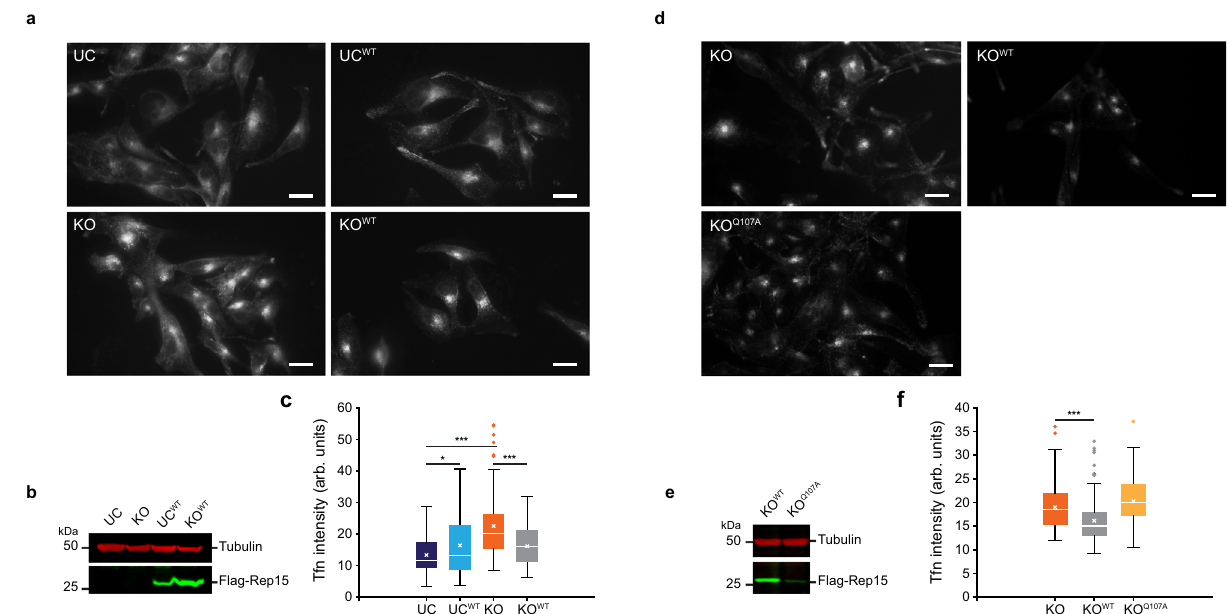
Fig. 9 Rep15 KO U138MG cells show reduced transferrin recycling. a Rep15 KO shows signi fi cant retention of Alexa-488-conjugated human transferrin in the 2 h chase post 30 min. internalization (representative pictures). Scale bar, 10 µ m. Overexpression of the WT-Rep15 further increased the transferrin retention in the WT cells (UC WT ; light blue bar) while, decreasing it, in the Rep15 KO cells (KO WT ; gray bar). b Western blot con fi rmation of the overexpression of Flag-tagged WT-Rep15. c Quanti fi cation of retained transferrin in the respective cell line presented in a ( n = 60; cells were examined over three independent experiments). d The rescued KO cells with the WT Rep15 (KO WT ; gray bar) show a signi fi cant reduction in the transferrin retention in the chase experiment, while the Q107A mutant (KO Q107A ; yellow bar) did not look different from the KO cells (representative picture). Scale bar, 10 µ m. e Western blot con fi rmation of the two Flag-tagged constructs. f Quanti fi cation of the transferrin from the cells presented in d ( n = 100; cells were examined over three independent experiments). Data are presented as box plot, showing mean (cross), median (line), 25 th and 75 th percentile (box). The whiskers extend to the most extreme data points not considered outliers, and the outliers are represented as dots. * p < 0.05, ** p < 0.01, *** p < 0.001, (unpaired, two tailed, Student ’ s t-test). Source data are provided as a Source Data fi le. n represent the number of cells analyzed for the transferrin assay from three biological repeats. The exact p values are provided in the Source data fi